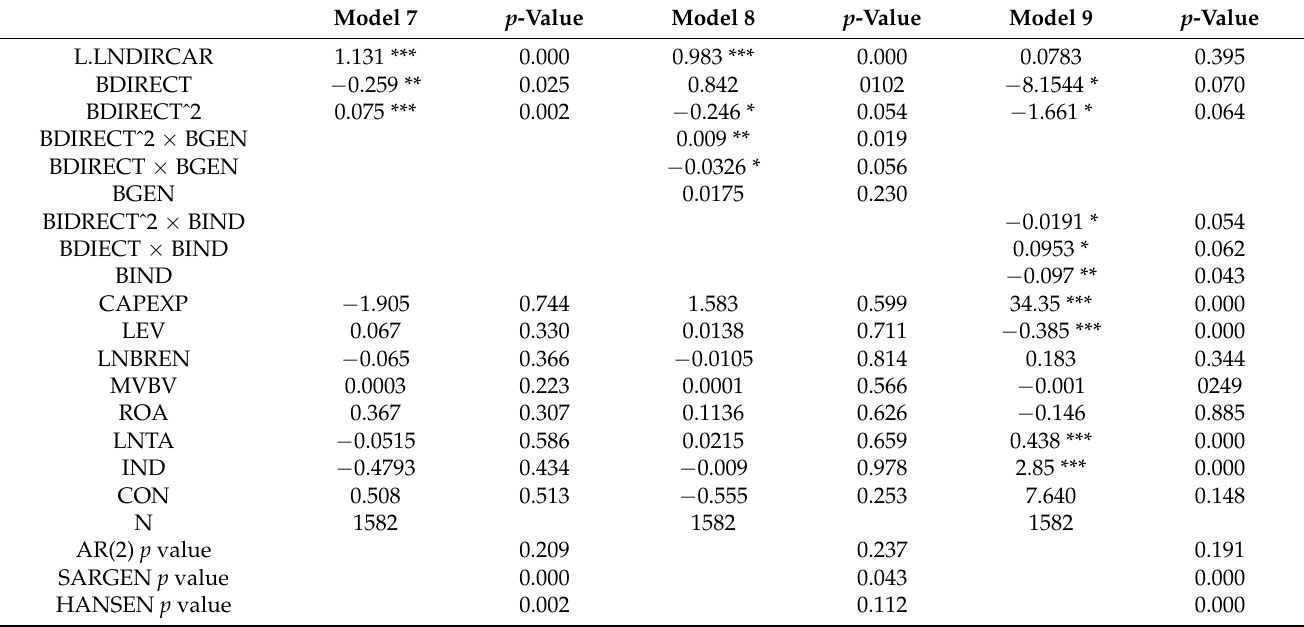
Table 8. Robust test: Models 7, 8, and 9.